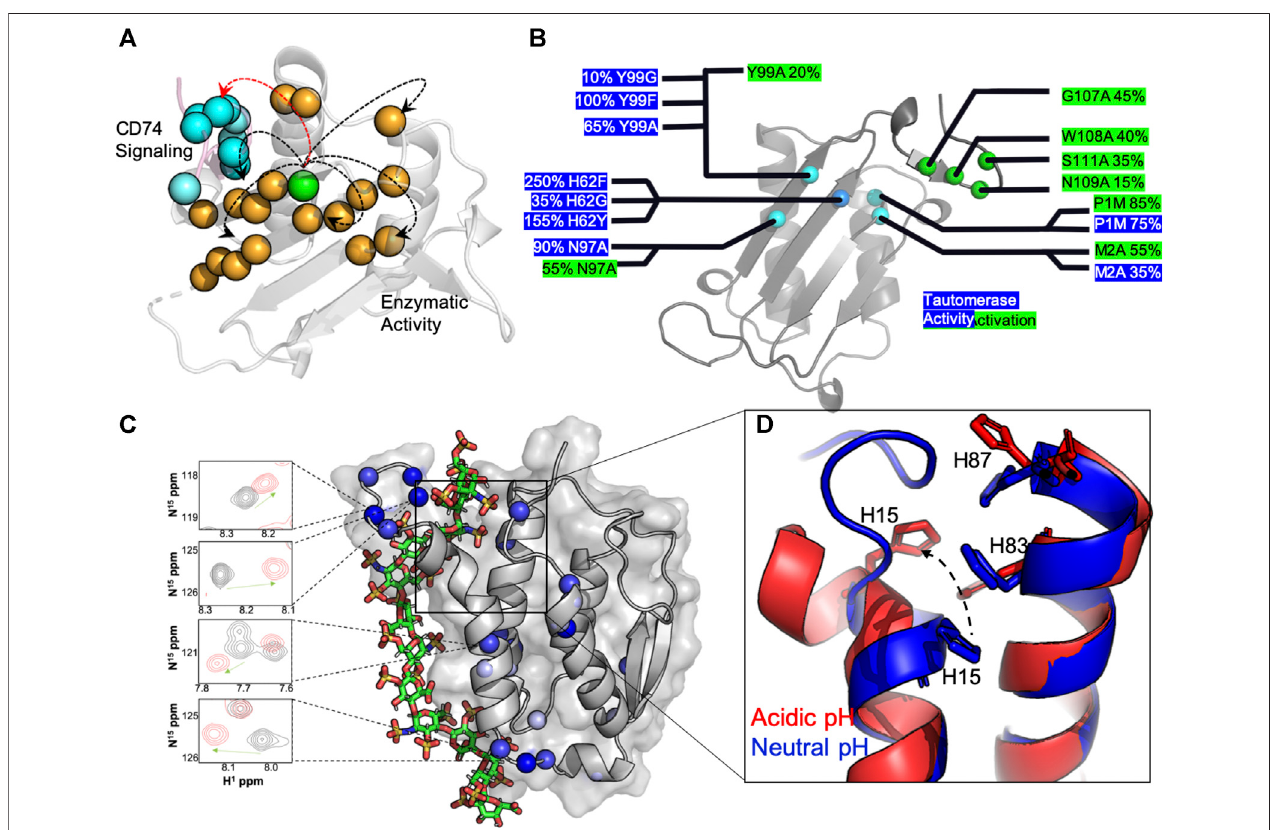
FIGURE 1 | Molecular insights from structure-function studies of MIF and GMCSF. (A) Tyr99 mutations (green) induce widespread NMR chemical shifts and line broadening (orange spheres), suggestingthat arelargeportion of theMIF structure “ senses ” short and long-range correlations (arrows) that in fl uence MIF signaling. The C-terminus of the adjacent MIF monomer, the site of CD74 activation, is shown in pink with blue spheres. (B) Experimental measurements of MIF activities determined from mutagenesis. Activity levels are presented as a percentage of wild-type (wt) MIF activity, with enzymatic catalysis (blue) determined from the enol-keto tautomerizationof4-hydroxyphenylpyruvate(4-HPP)(Lubetsky etal.,1999)and CD74activation(green)determined fromtherecruitmentofneutrophilstomurinelungs in vivo (Takahashi et al., 2009). (C) A computationally-derived GMCSF structure in the presence of a heparin oligo at pH 5.5. Experimental NMR chemical shift perturbations (blue spheres) are mapped onto GMCSF, and NMR resonances in the presence (red) and absence (black) of heparin are shown to correlate with the proposed binding site. D) An overlay of GMCSF structures at pH 7.4 (blue, PDB: 2GMF) and pH 5.5 (red, from simulations), where disruption of H15, H83 and H87 pi- stacking alignment is clear at acidic pH and in the presence of